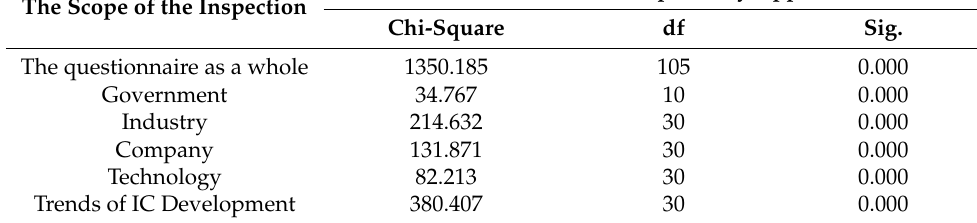
Table 5. The result of Bartlett.